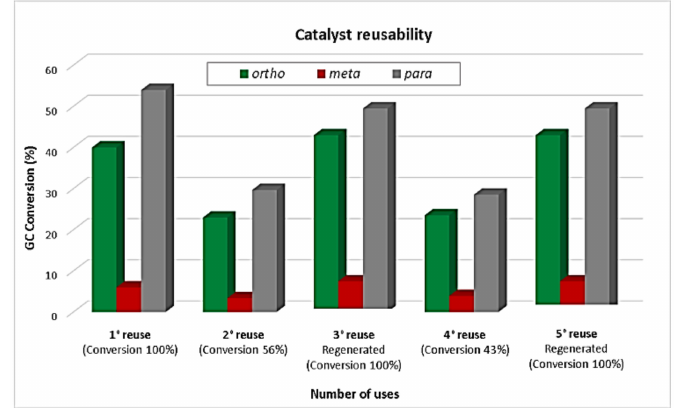
Figure 8. Reusability experiments of Zn/MCM-41(15) in the alkylation of toluene with benzyl chloride. Reaction conditions: 1 mL toluene, 0.1 mL benzyl chloride, 12.5 mg Zn/MCM-41(15), 5 min, MWs, 120 ◦ C, 300